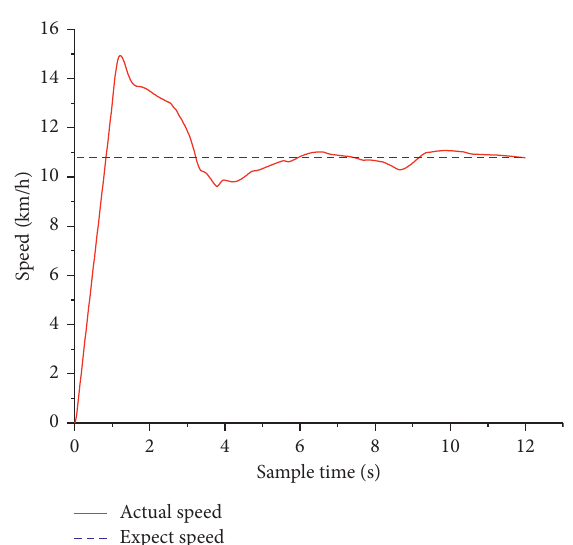
Figure 27: Comparison of horizontal